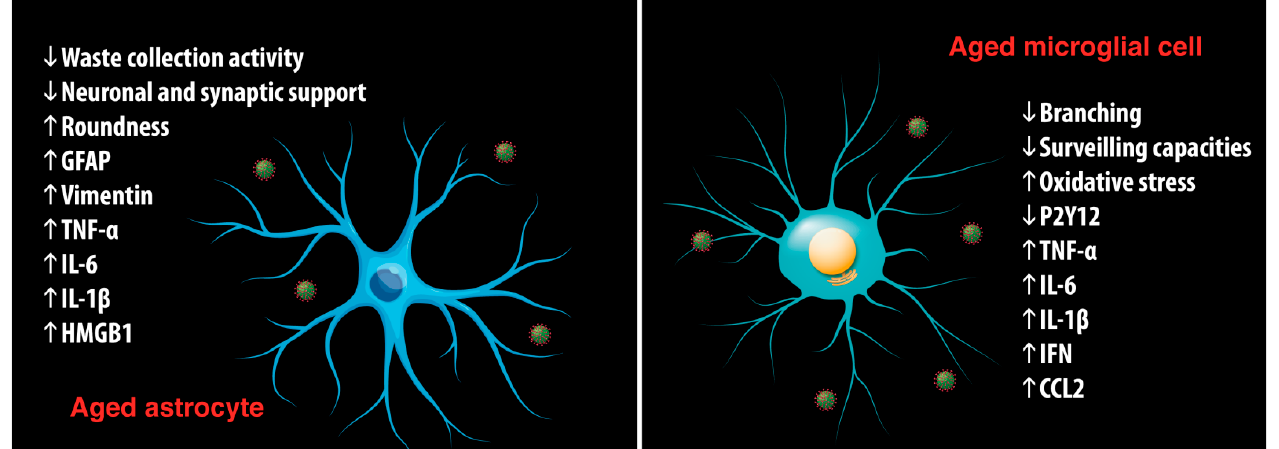
Figure 2. Age-associated changes of astrocytes and microglia amplifying the negative effects of SARS-CoV-2. Aged as- trocytes undergo functional changes such as decreased waste collection activity and neuronal support. In addition, they show increased levels of glial fibrillar acidic protein (GFAP) and vimentin filaments as well as increased expression of several cytokines and high mobility group box 1 protein (HMGB1). Aged microglia show decreased branching and sur- veilling capacities as well as increased oxidative stress. The production of chemokines and cytokines such as TNF- α , IL-6, IL-1 β , IFN and CCL2 is significantly increased. All of these changes determine a specific vulnerability of the aged brain to SARS-CoV-2